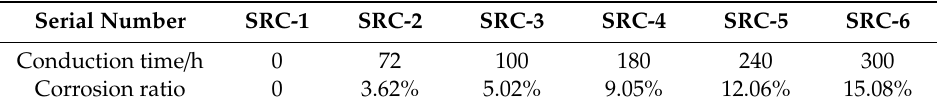
Table 3. Relationship of conduction time and corrosion ratio.